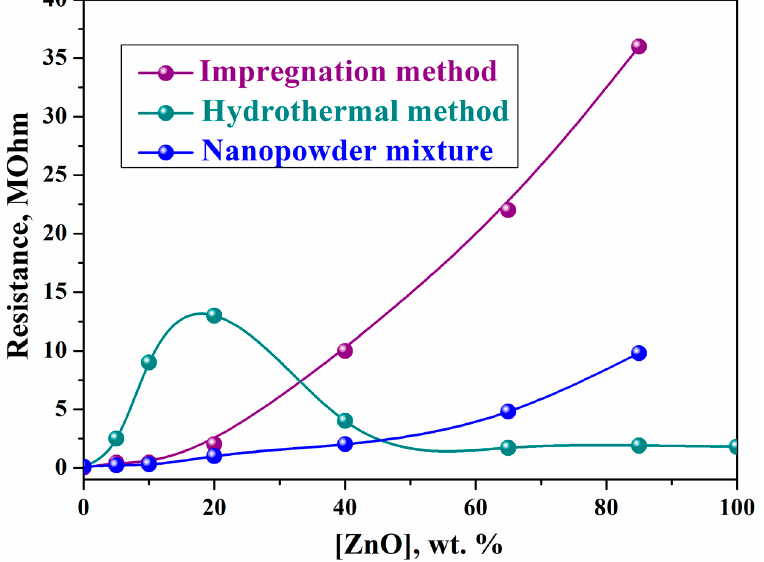
Figure 3. Dependence of the resistance of the ZnO–In 2 O 3 composites synthesized by different methods on the content of zinc oxide.